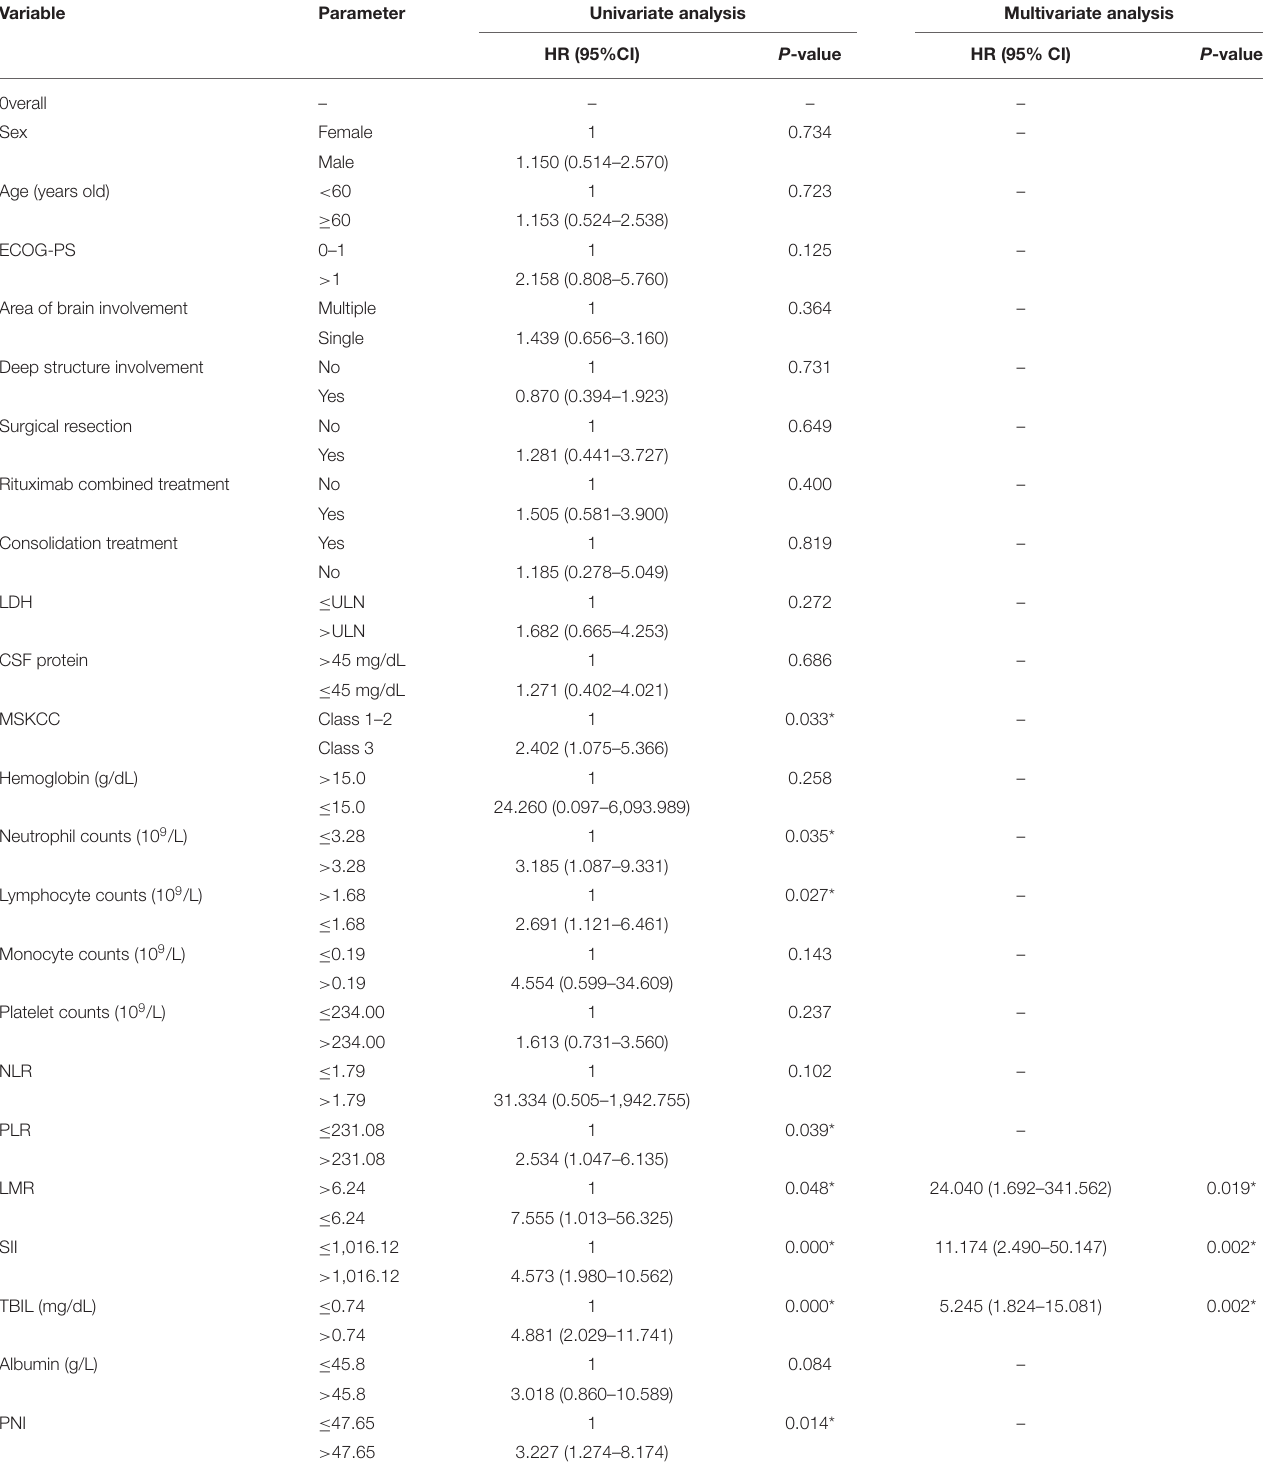
TABLE 4 | Univariate and multivariate analysis of OS.